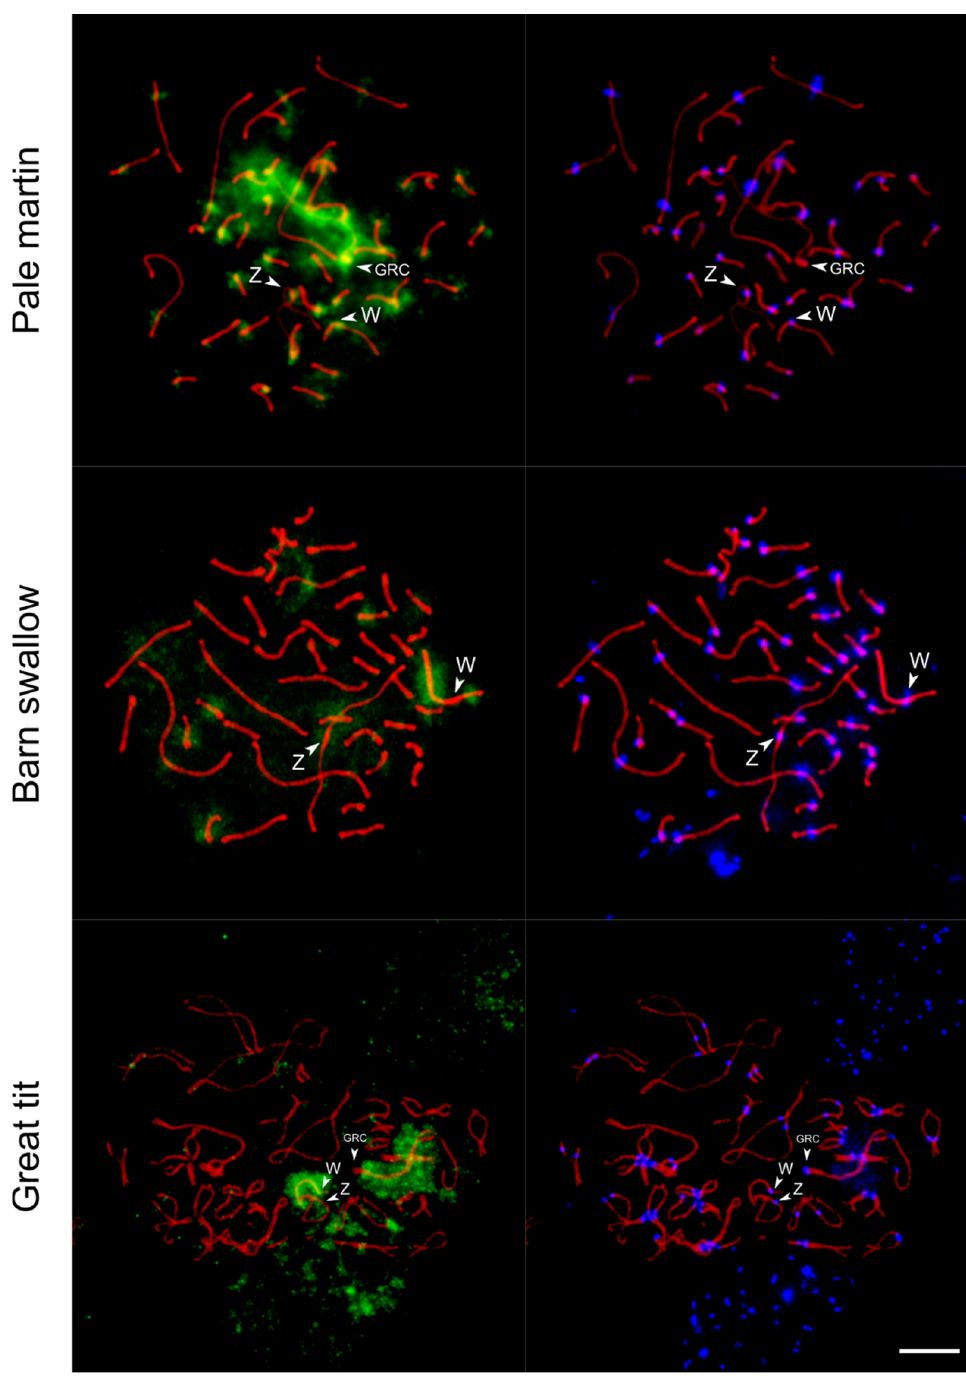
Figure 4. FISH with pale martin GRC-specific probe (green) on pachytene oocytes of pale martin and barn swallow and diplotene oocyte of great tit immunostained with antibodies to SYCP3 (red) and centromere proteins (blue). Arrowheads show centromeres of Z, W and GRC chromosomes. In barn swallow, GRC is one of the microchromosomes. Bar—5 μ m.